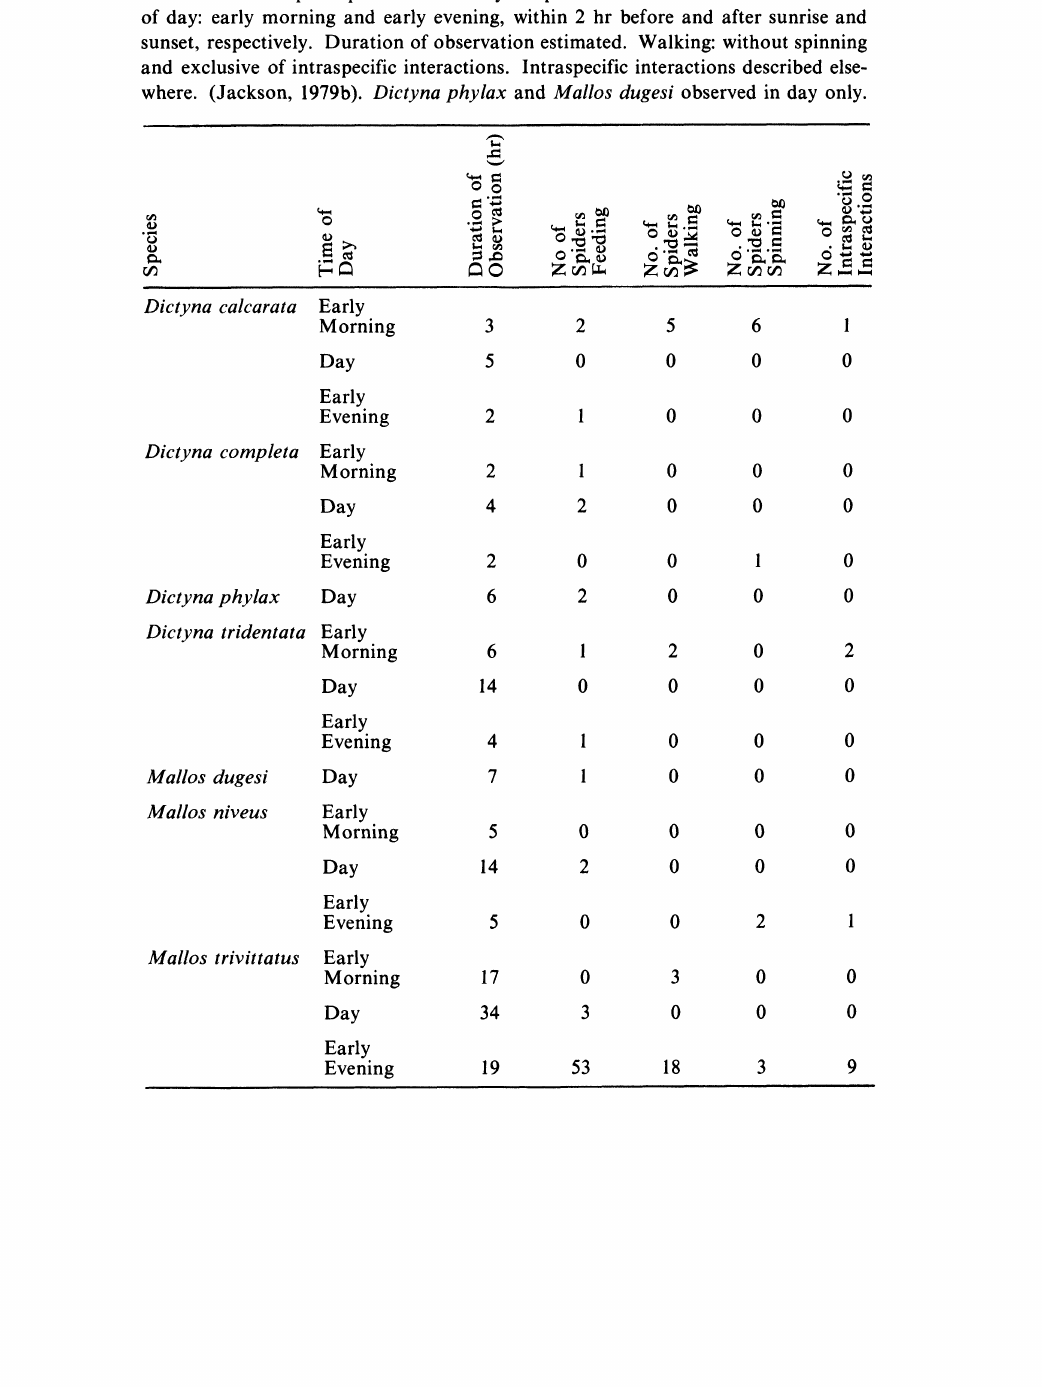
Dictyna calcarata Early